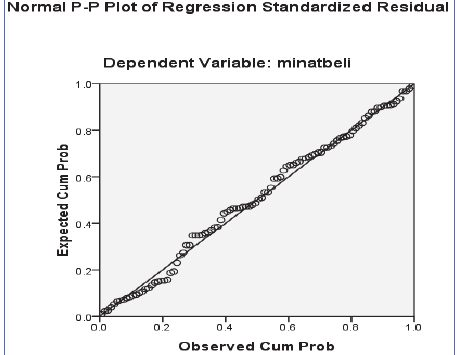
Fig. 1. Normality Test